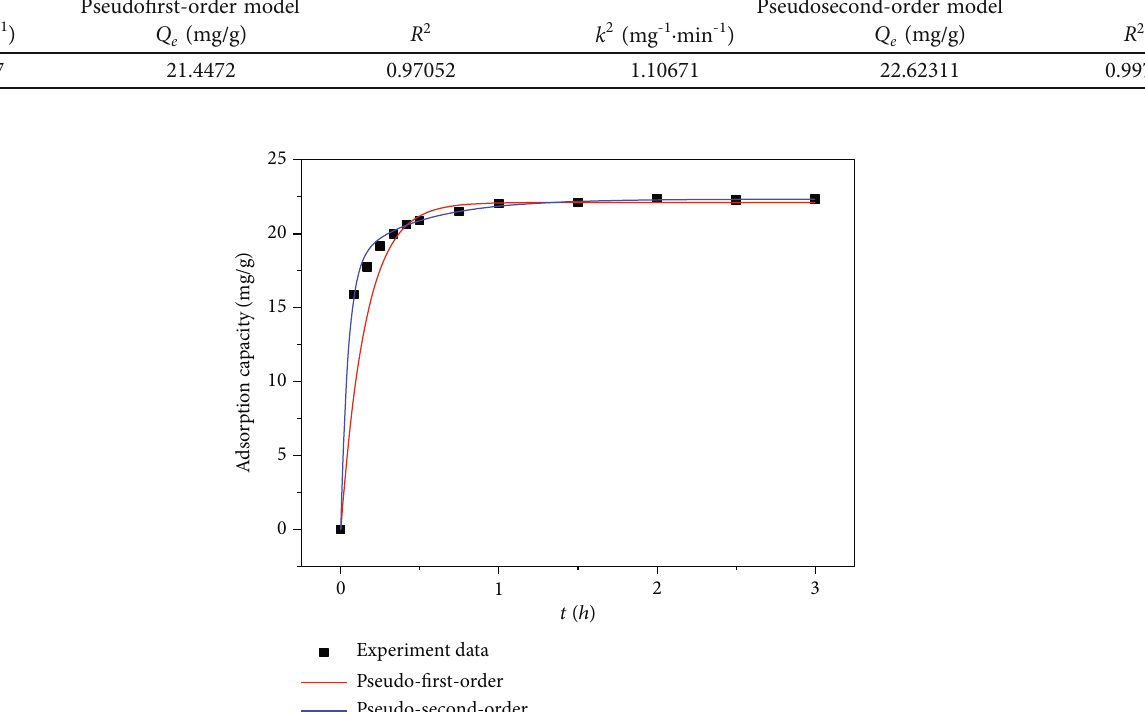
Table 8: Pseudo fi rst-order and pseudosecond-order kinetic model parameters for Cr (VI) adsorption of CSBT. Pseudo fi rst-order model